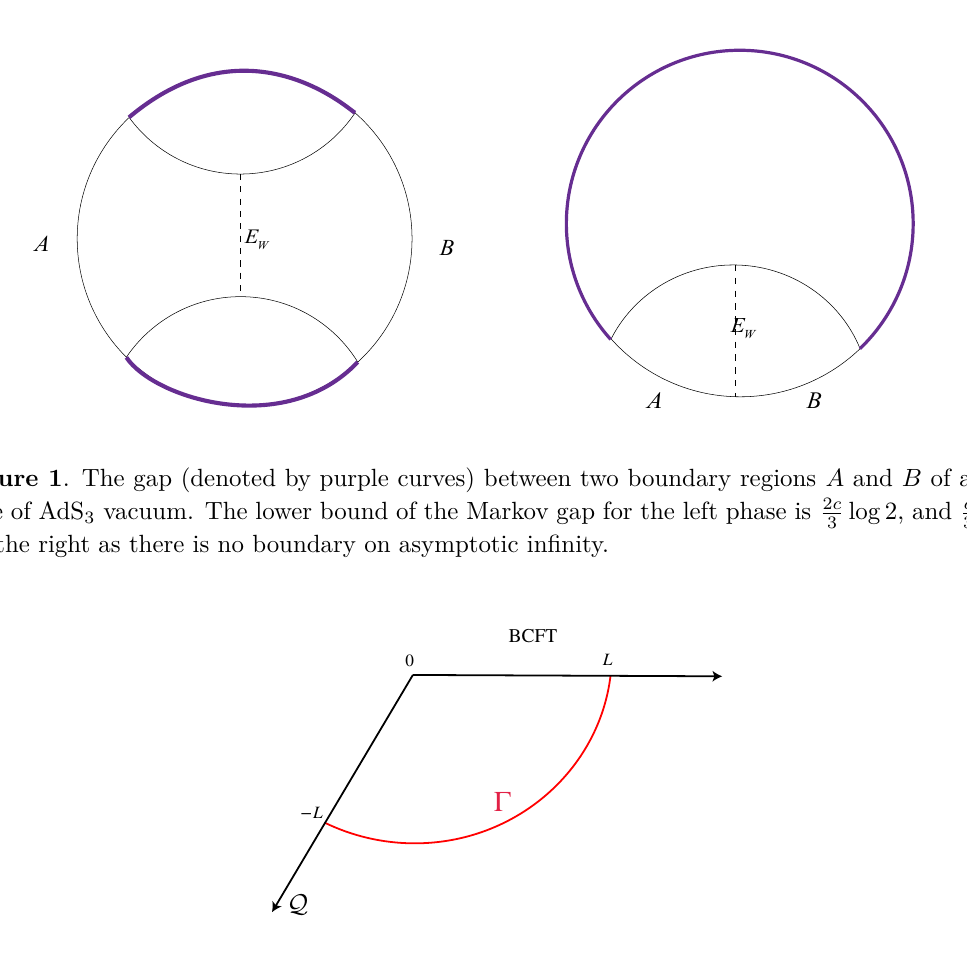
Figure 2 . The holographic dual of BCFT on a half space in